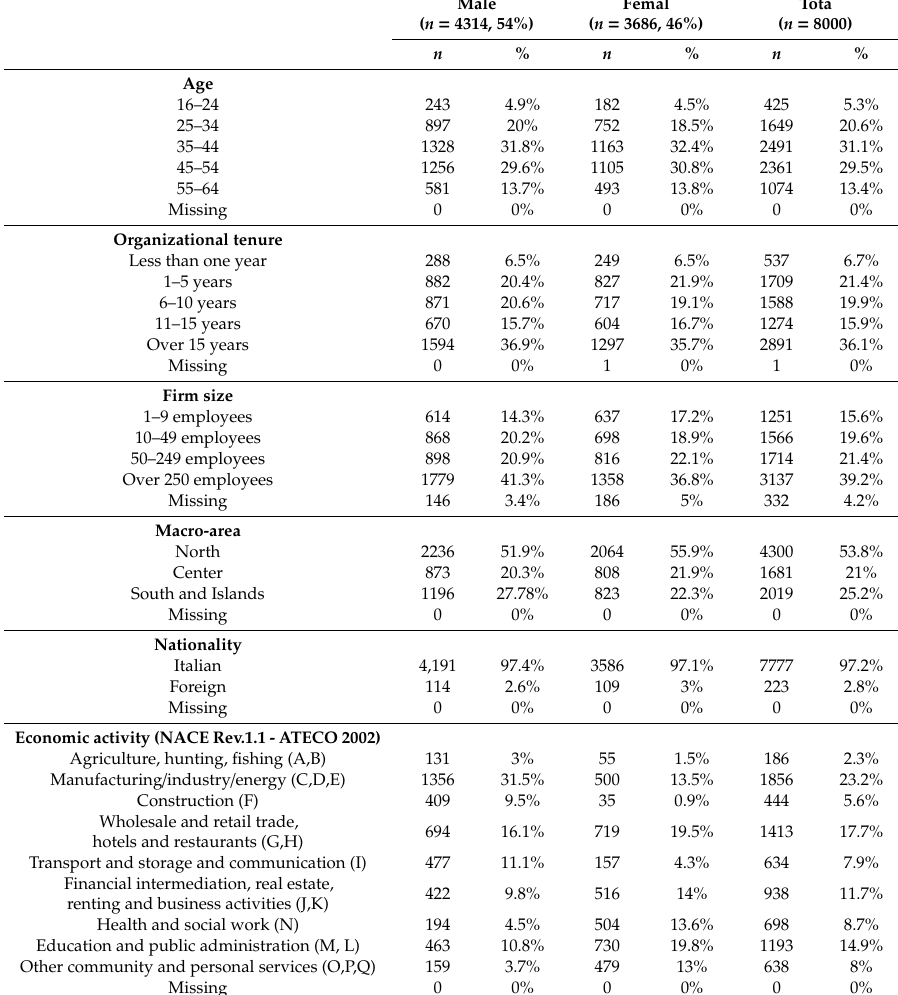
Table 1. Socio-demographic and occupational characteristics of the study sample ( n = 8000).